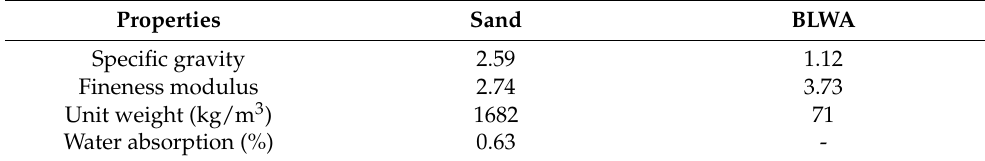
Table 2. Physical properties of fine aggregates.